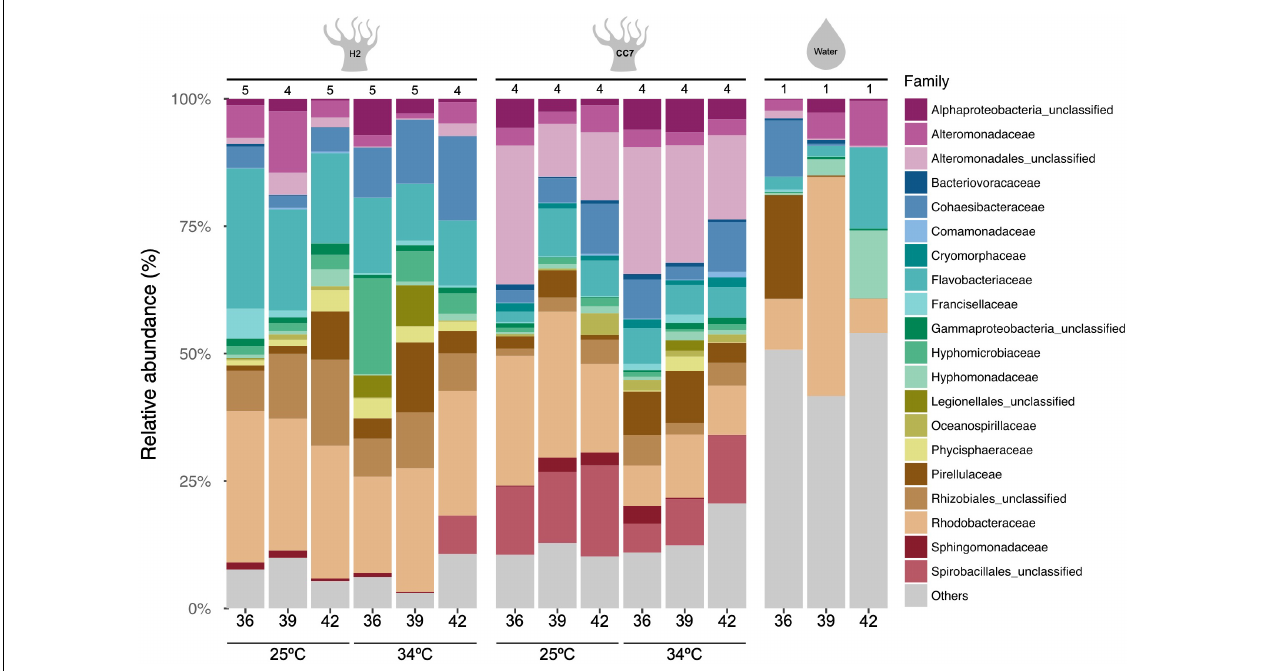
FIGURE 1 | Taxonomy bar chart of bacterial families (Greengenes database, bootstrap ≥ 60) of Aiptasia host-algal symbiont pairings (H2-SSB01, CC7-SSA01) and seawater samples across temperatures and salinities. Each bar denotes the mean percentage of 16S rRNA gene sequences across replicates for each host and treatment (number of replicates are denoted above bars). Each color represents one of the twenty most abundant families across samples. The “Others” category groups the less abundant families.